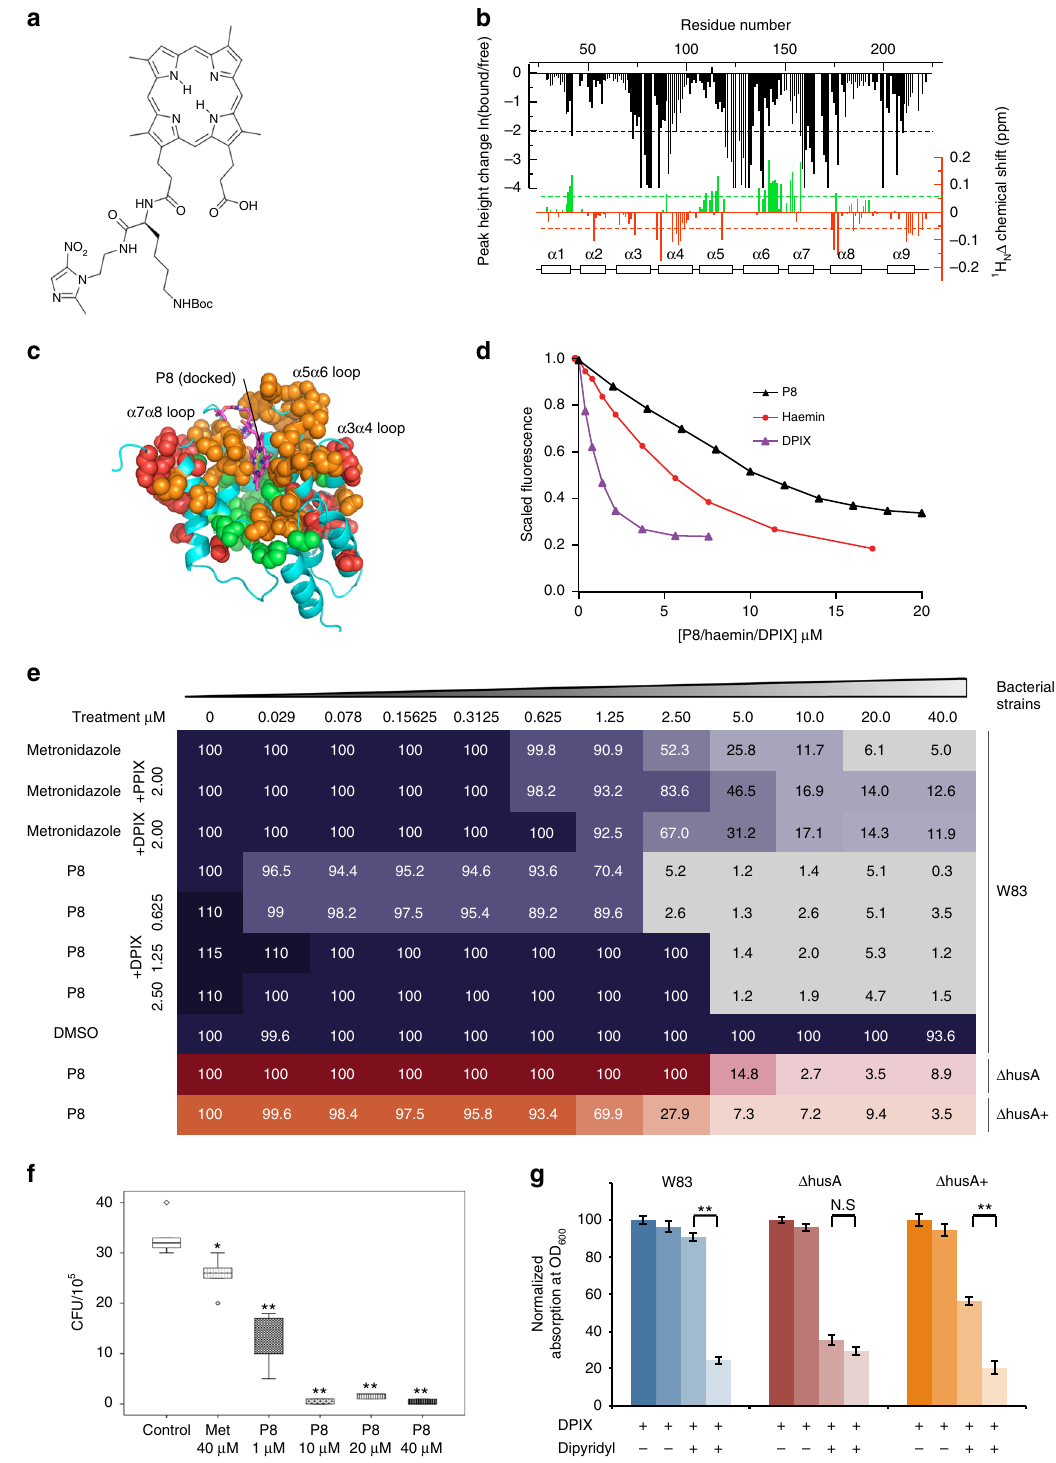
ring current effects. Similar docking solutions were obtained for both NMR conformer sets and for all three ligands (analysis shown in Supplementary Figure 20a); although, the ‘ inward ’ facing position of the W130 indole ring (NMR conformer set 2) tended to restrict binding to one end of the hydrophobic groove (Fig. 2g, purple sticks). Docking solutions with inward facing W130 side chain were also obtained when docking to NMR